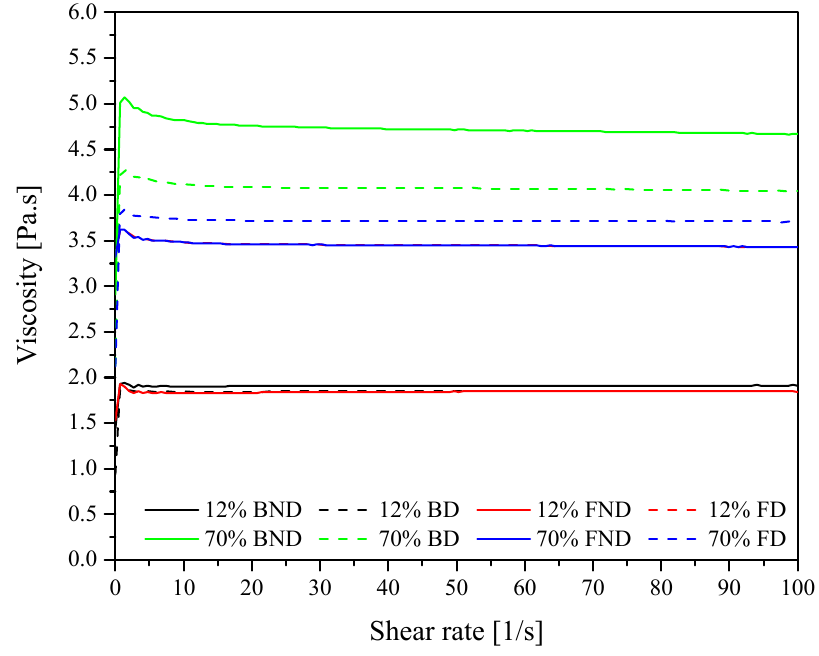
Figure 11. DMA rheology diatoms/epoxy resin composition, BND—base diatomite non degassed, BD—base degassed, FND—fracionated non degassed, FD—fracionated degassed.